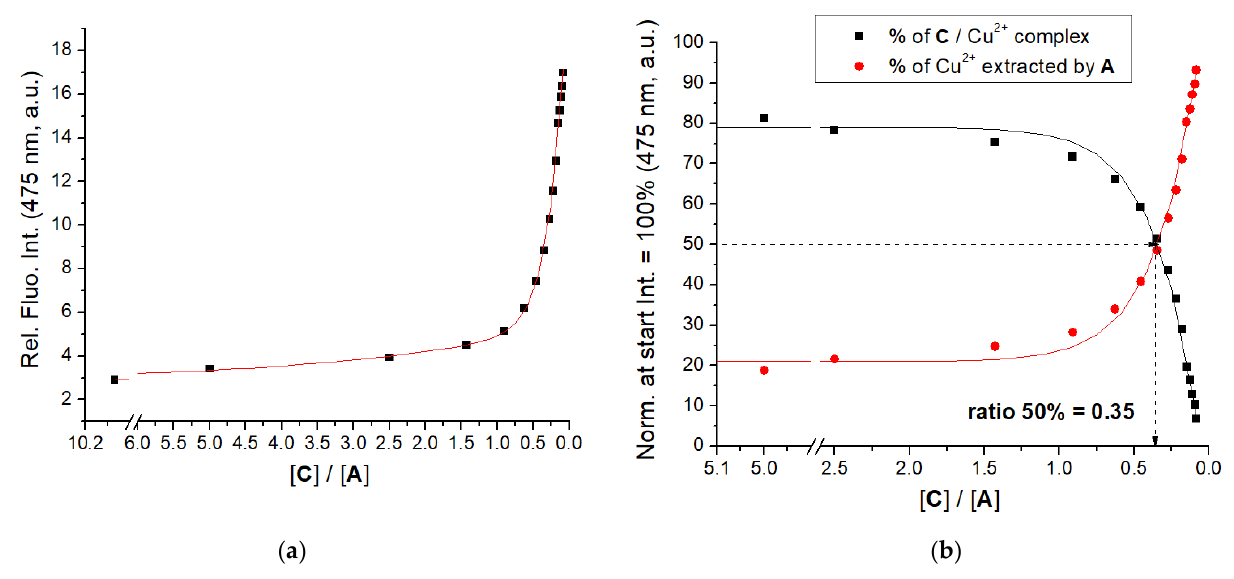
Figure 4. ( a ) Changes in fluorescence of C ( c = 1 × 10 −6 M, λ exc = 353 nm, λ em = 475 nm) in the complex with CuCl 2 ( c = 1 × 10 −6 M) upon addition of A ; ( b ) the percentage of C or Cu 2+ released from the C /Cu 2+ complex. Done at pH 7.0; sodium cacodylate buffer, c = 50 mM.